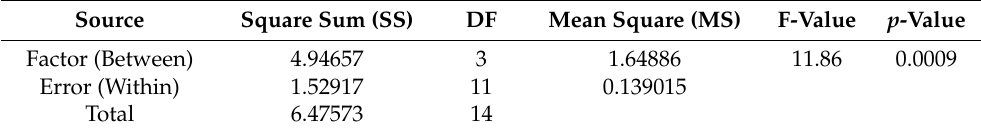
Table 16. Effect of P2 fiber type and temperature on f R,b by applying ANOVA analysis. Source Square Sum (SS) DF Factor (Between) Error (Within)